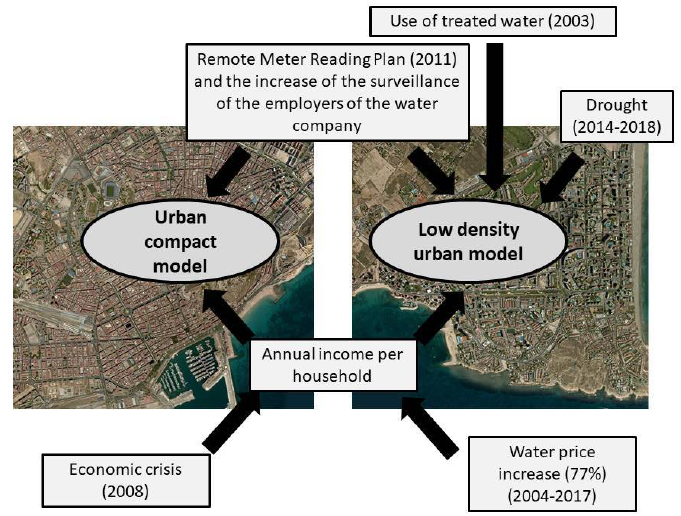
Figure 5. Relationship of factors that influence unauthorised domestic water consumption in the city of Alicante. Own elaboration.